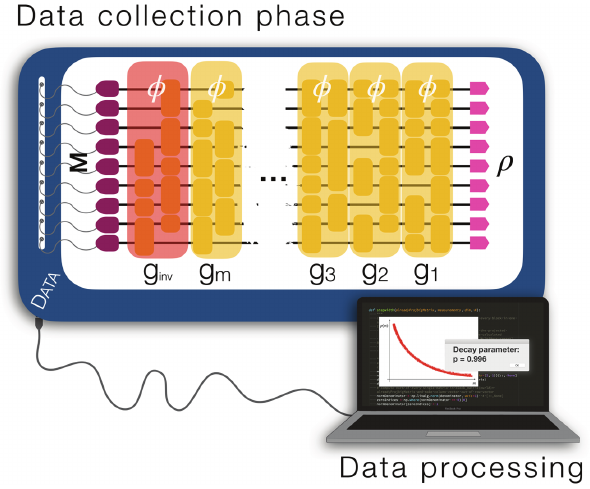
FIG. 4. Illustration of a prototypical RB protocol. After the preparation of an initial state, one applies a random sequence of unitaries g = ( g 1 , . . . , g m ) succeeded by an inversion gate and final measurement of M . This experiment is repeated for differ- ent sequences and different sequence lengths m . In the classical postprocessing, the decay parameter of resulting empirical esti- mates for different sequence lengths m are extracted and reported as the RB